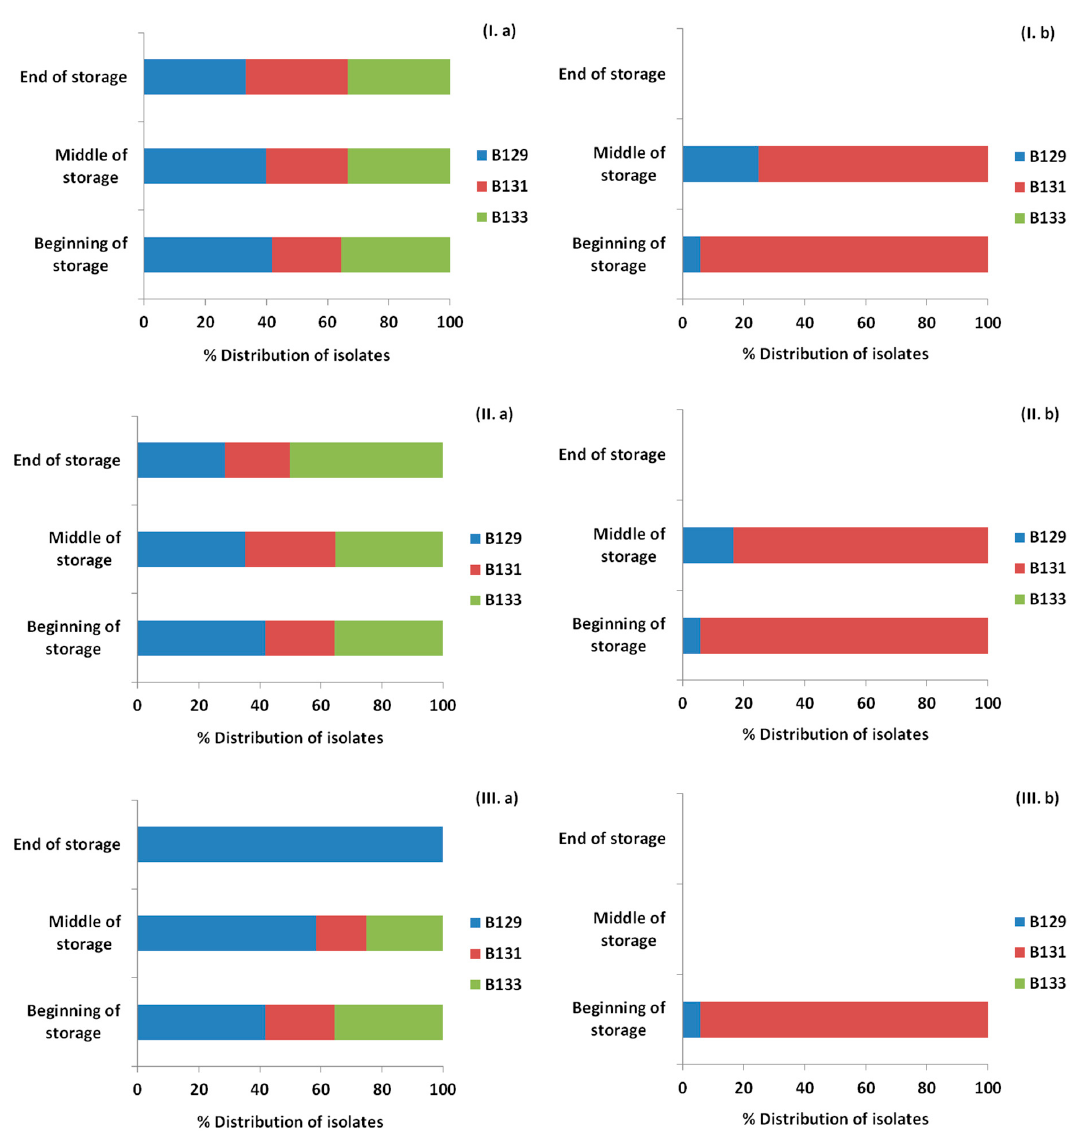
Figure 8. Distribution (%) of Listeria monocytogenes strains recovered from ham slices at three time points (beginning, middle, end) during storage at 4 °C based on the pulsed field gel electrophoresis (PFGE) profiles, for control samples ( I ), samples with edible film free from oregano essential oil—OEOF ( II ), samples with edible film supplemented with oregano essential oil—OEOS ( III ), without ( a ) or after ( b ) high pressure processing